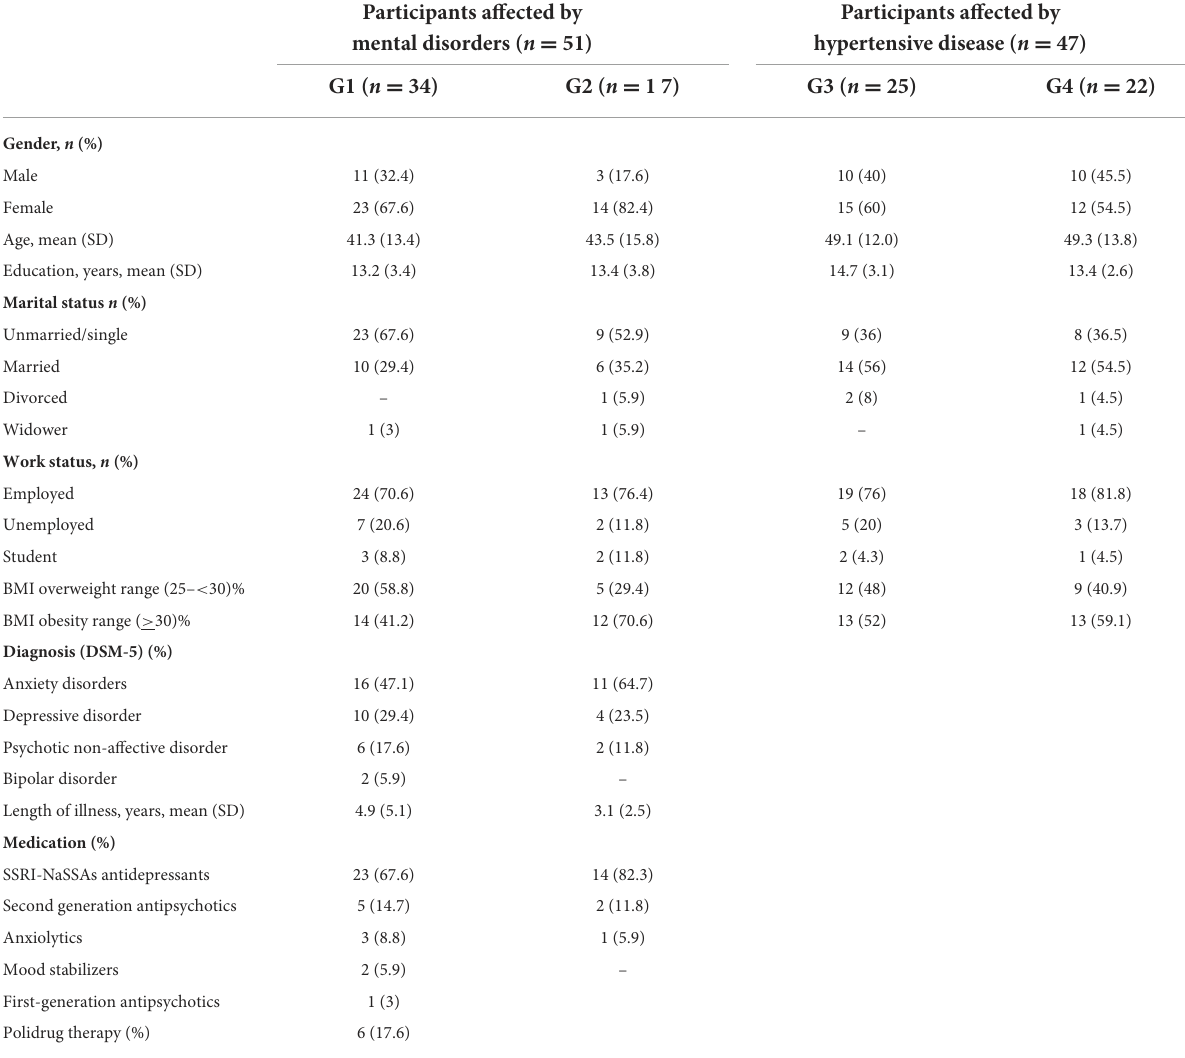
Participants affected